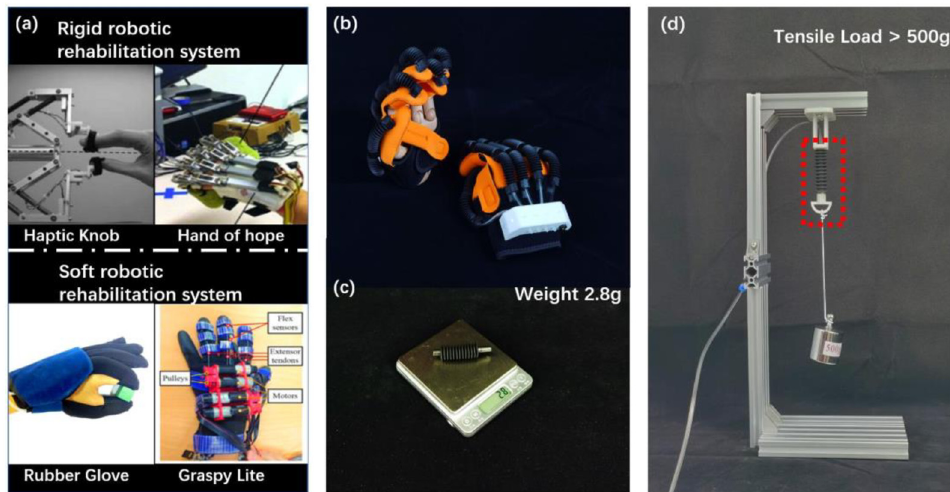
Figure 1. ( a ) Existing robotic hand dysfunction rehabilitation system; ( b ) soft exoskeleton rehabili- tation gloves actuated by multi-GBBAs; ( c ) the weight of a single GBBA is 2.8 g; ( d ) tensile load exceeding 178 times GBBA’s own weight.